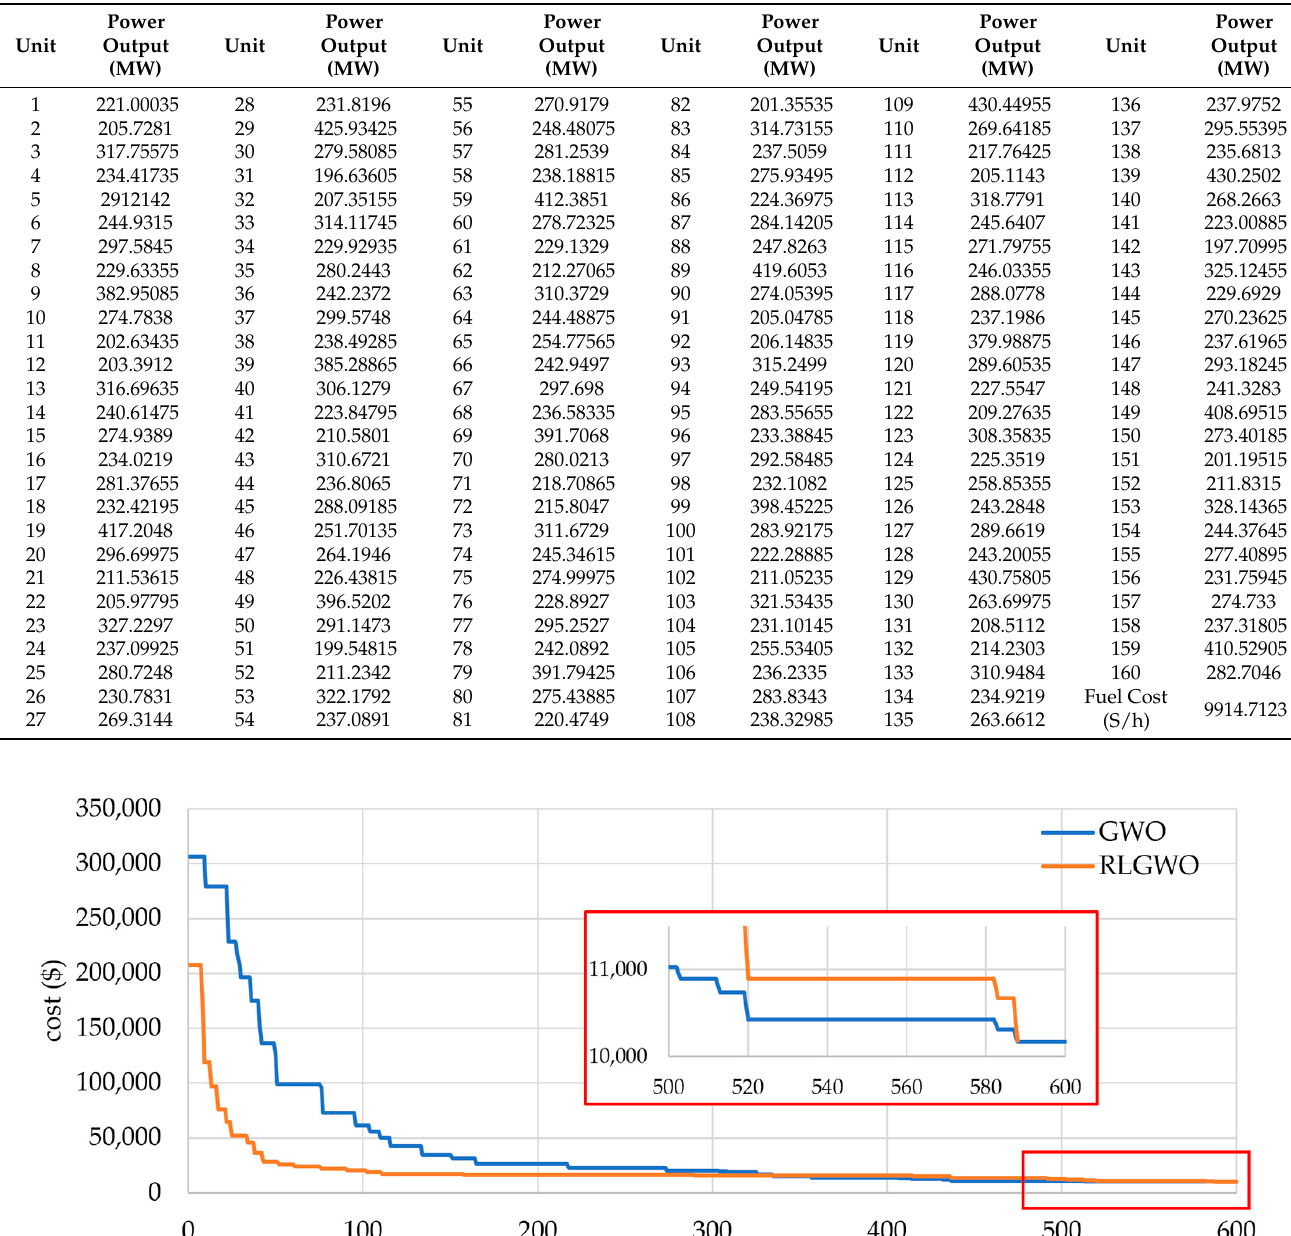
Table 9. Best simulation results for the 160-unit system with loss ( P D = 43,200 MW).